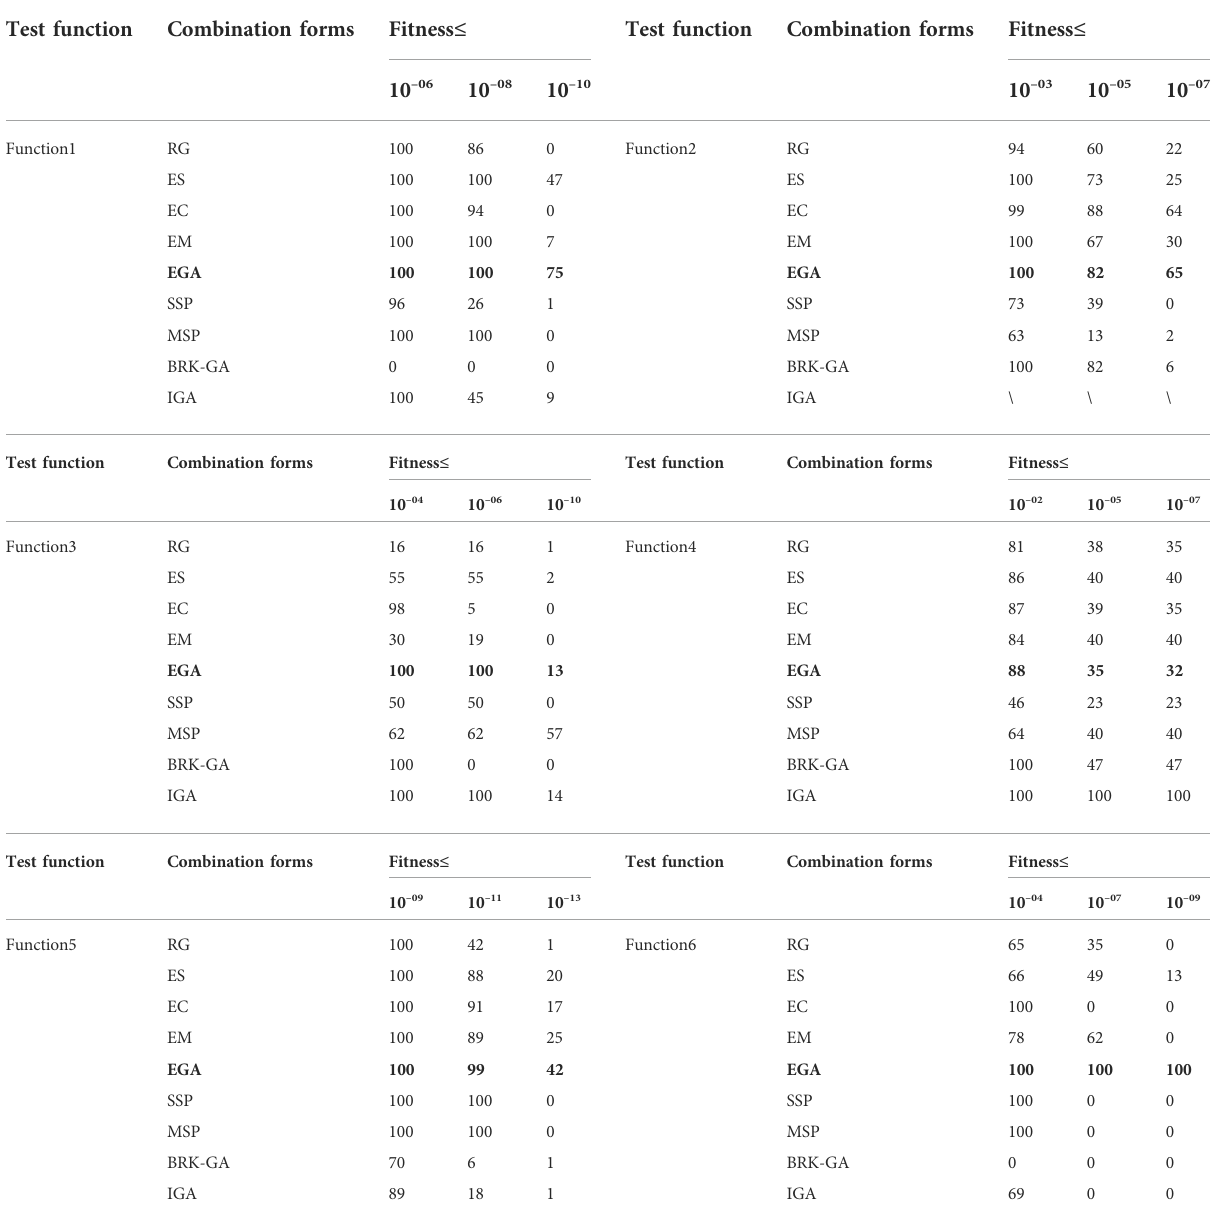
TABLE 5 Convergence analysis for each evolutionary process of design